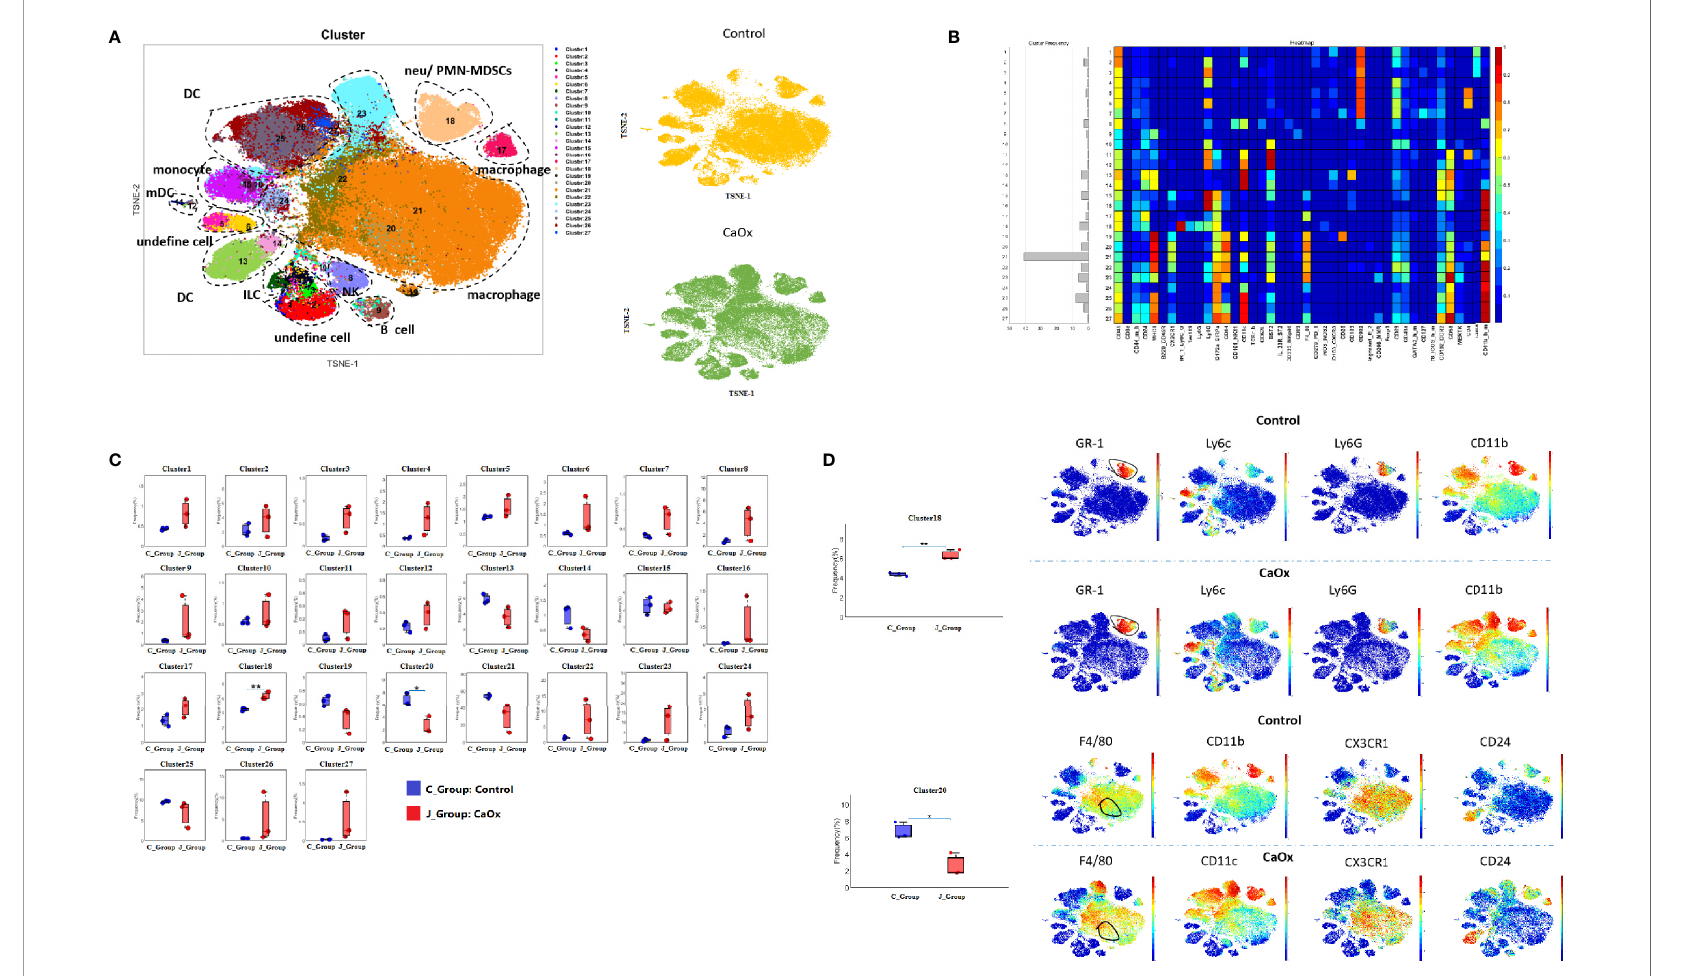
FIGURE 3 | Identi fifi cation of Non-CD3+ and Non-CD19+ cell populations in kidney using mass cytometry. (A) tSNE visualization of Non-CD3+ and Non-CD19+ cell populations by X-shift algorithm. (B) Heatmap of different markers in different clusters. (C) Frequencies of 27 clusters between groups. (D) Phenotypical characteristics of signi fifi cant differential clusters between control and CaOx mice. Statistically signi fifi cant was shown as *p < 0.05, **p <